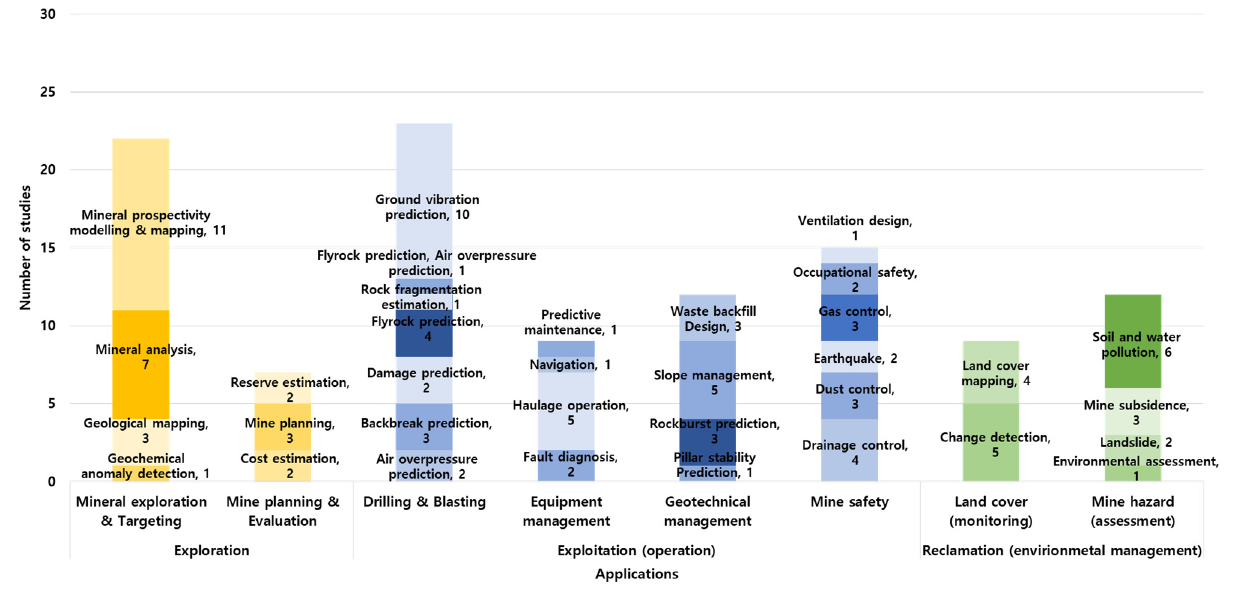
Figure 5. Detailed graph presenting the number of publications.